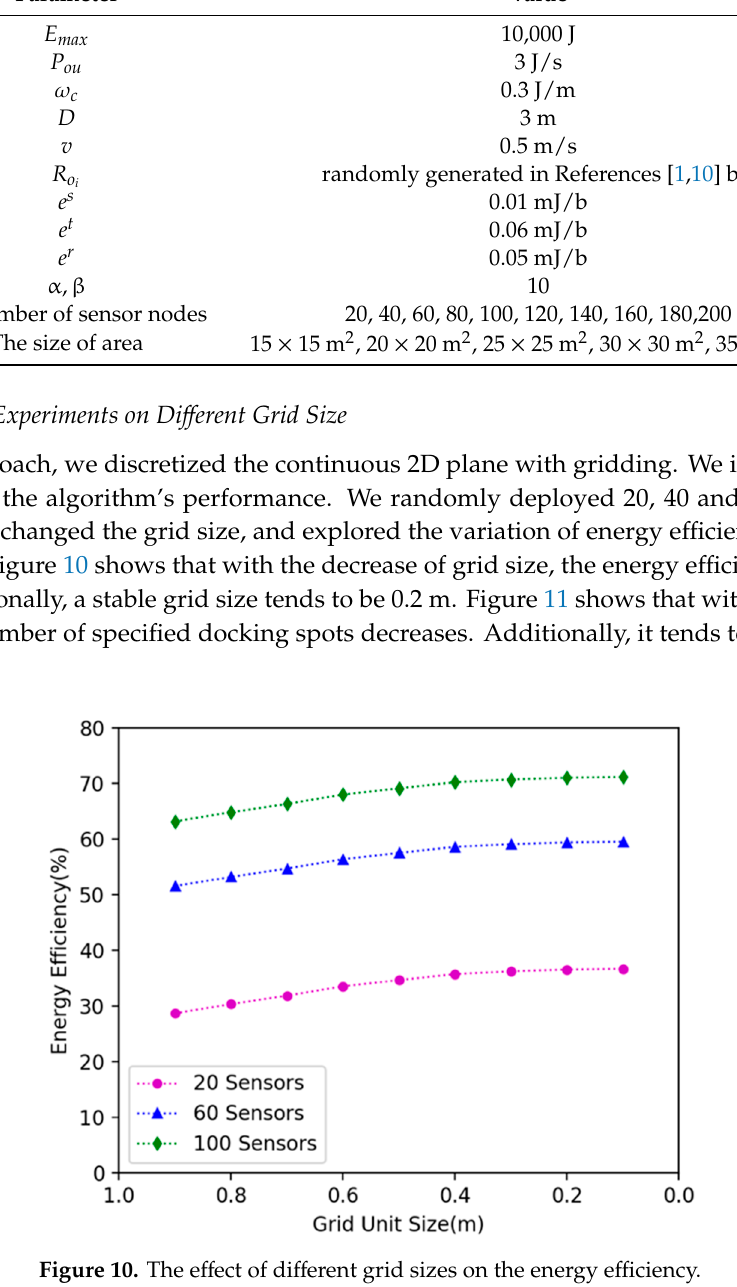
Figure 11. The effect of different grid sizes on the number of specified docking spots. 6.2. Comparison Experiments on Different Network Size And Area Size We investigated how network size affects the algorithm’s performance. We randomly deployed 20, 40, 60, 80, 100, 120, 140, 160, 180, 200 nodes in 15 × 15 m 2 , 20 × 20 m 2 , 25 × 25 m 2 , 30 × 30 m 2 ,35 × 35 m 2 plane areas respectively, and explored the variation in the energy efficiency of DCV. It can be seen in Figure 12 that as the number of nodes increases, the energy efficiency increases; because the number of nodes increases in the same area, the number of nodes can be covered by the DCV increases, so more energy is received by the nodes, and the energy efficiency is improved. As shown in Figure 13, when the number of nodes remains unchanged and the area becomes larger, the energy efficiency decreases. This is because as the area becomes larger, the distance between nodes becomes larger, the moving path of the DCV becomes longer, and the energy consumed on moving increases, which leads to the decrease of the energy efficiency of the DCV.